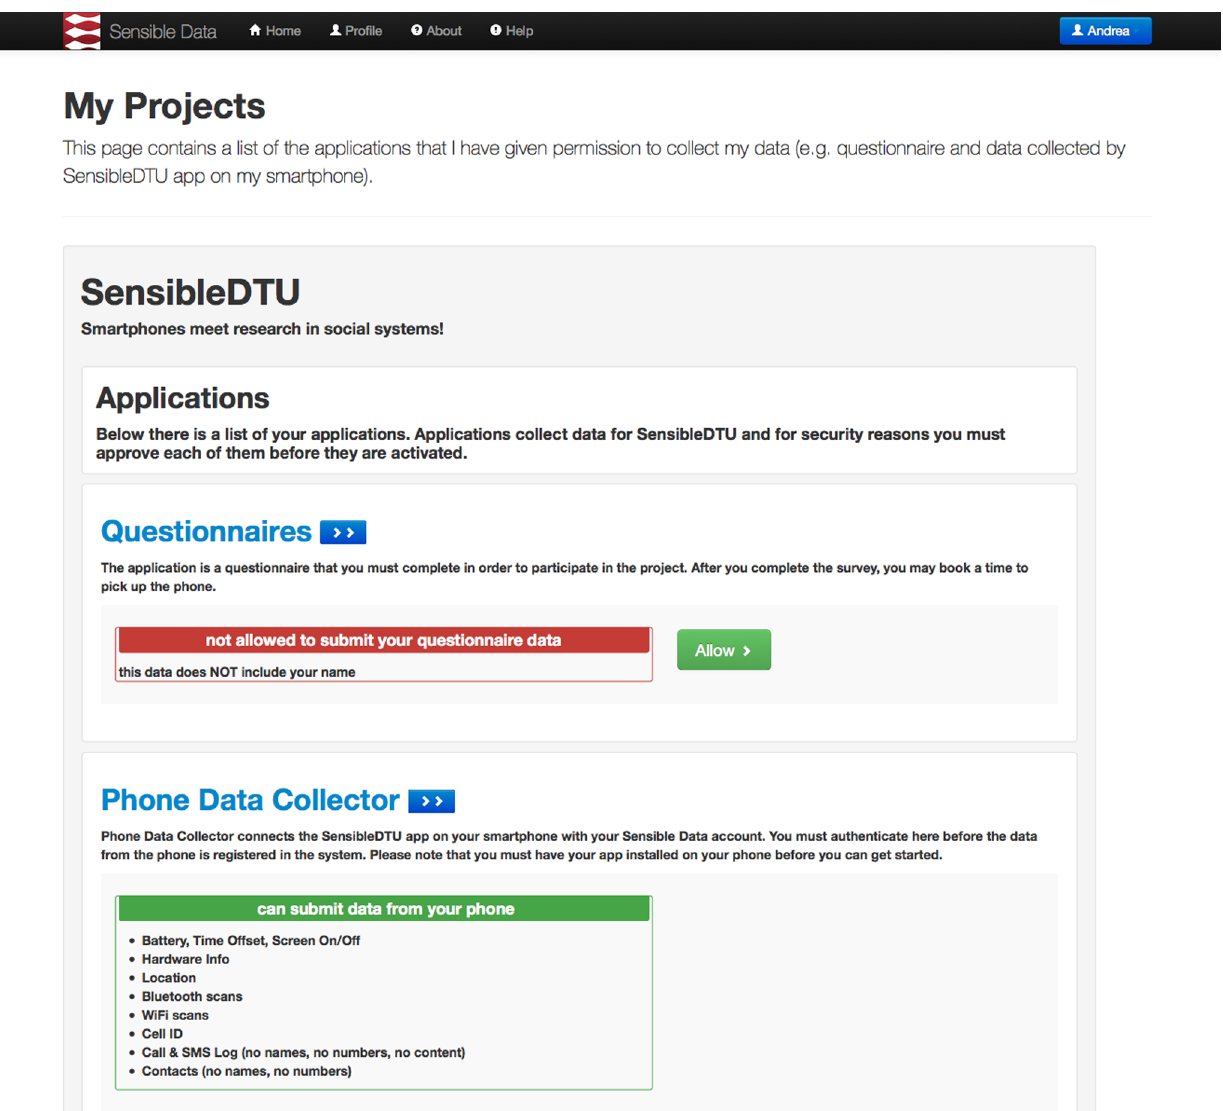
Figure 3. Authorizations page. Participants have an overview of the studies in which they are enrolled and which applications are able to submit to and access their data. This is an important step towards users’ understanding what happens with their data and to exercising control over it. This figure shows a translated version of the original page that participants saw in Danish.